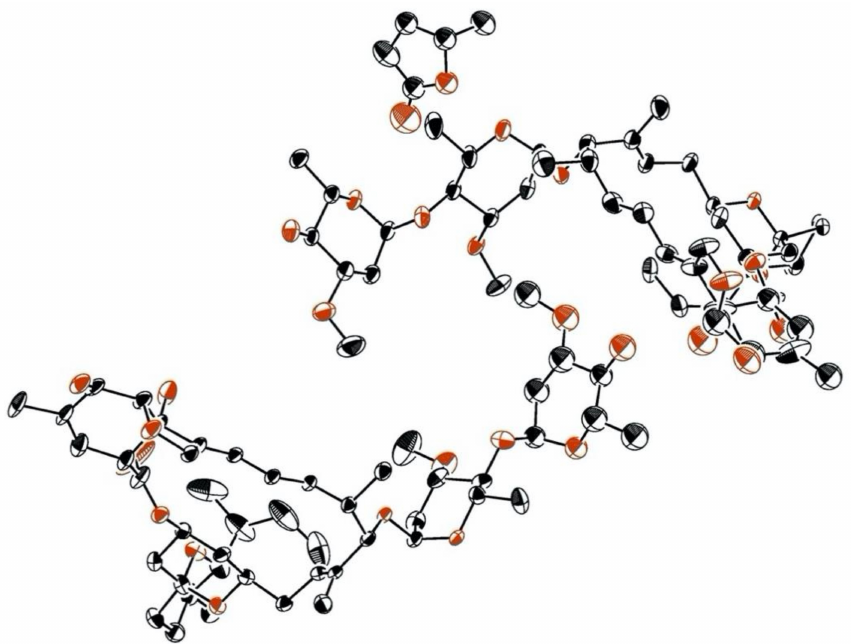
Figure 6. ORTEP diagram of two independent molecules of IVM in the asymmetric unit of crystal II showing thermal ellipsoids with a 50% probability level. For the sake of clarity, hydrogen atoms and solvent have been